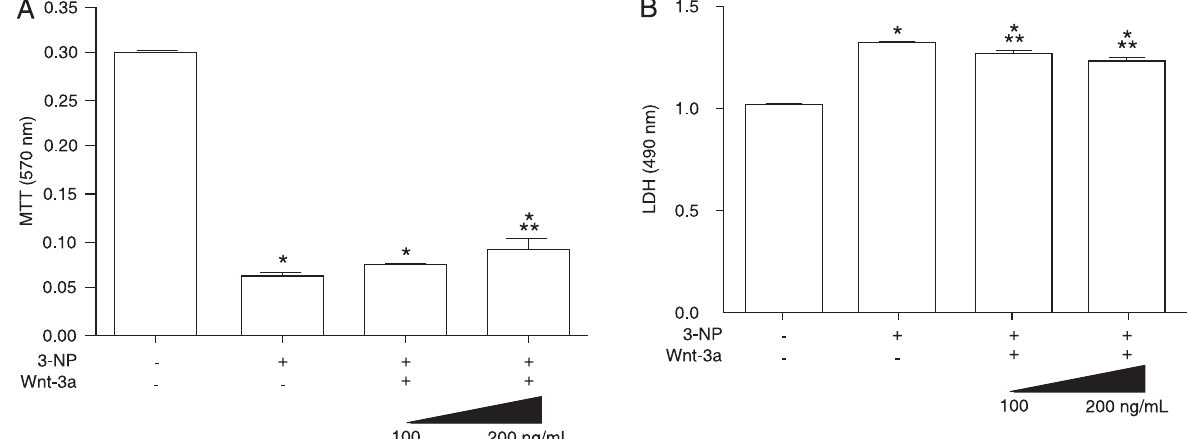
Figure 5. Effect of two concentrations of Wnt-3a peptide against 3-nitropropionic acid (3-NP) toxicity. PC12 cells were incubated with Wnt-3a (100 or 200 ng/mL) for 24 h followed by incubation with 5 mM 3-NP for 24 h. Twenty-four hours later, cell viability was mea- sured by A , MTT reduction (570 nm) and by B , lactate dehydrogenase (LDH) release (490 nm). Data are reported as means ± SEM for 6 independent experiments. *P < 0.001 vs control (vehicle: 0.08% ethanol), **P < 0.05 vs 3-NP (one-way ANOVA followed by the Newman-Keuls test).